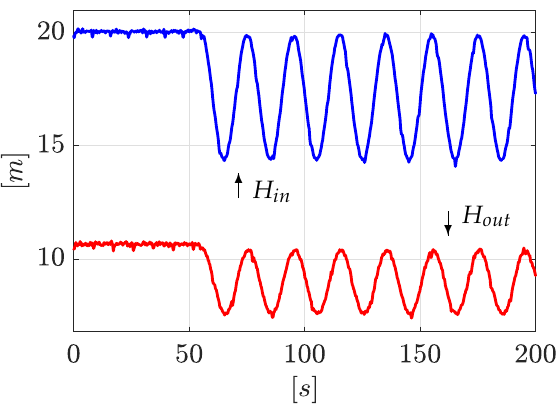
Figure 8. Pressure heads H in and H out (2nd experiment).